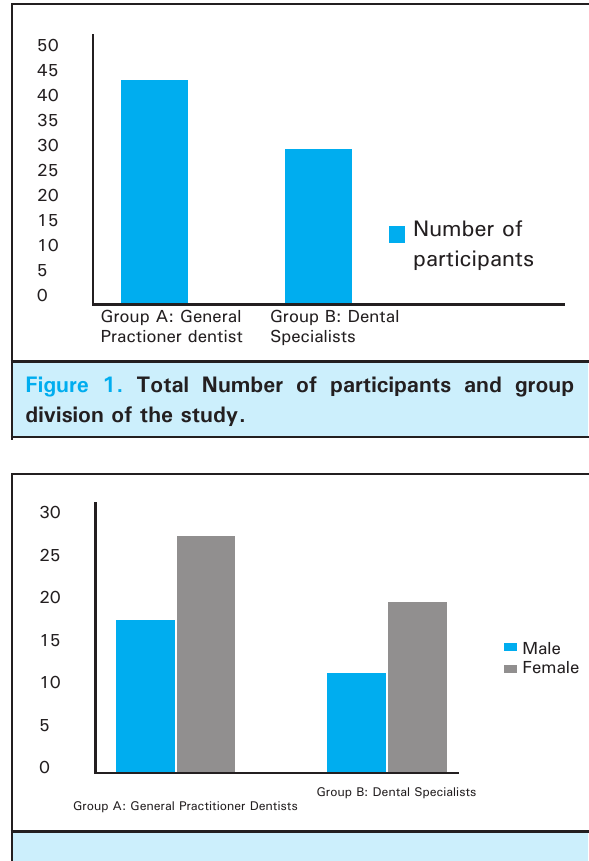
Figure 2. Sex distribution of the